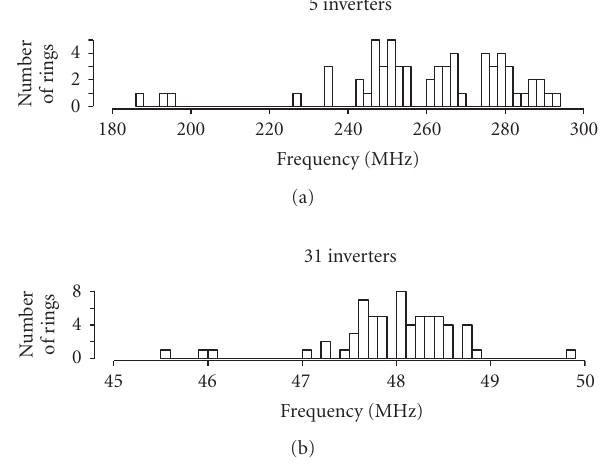
Figure 6: Histogram of ring frequencies.